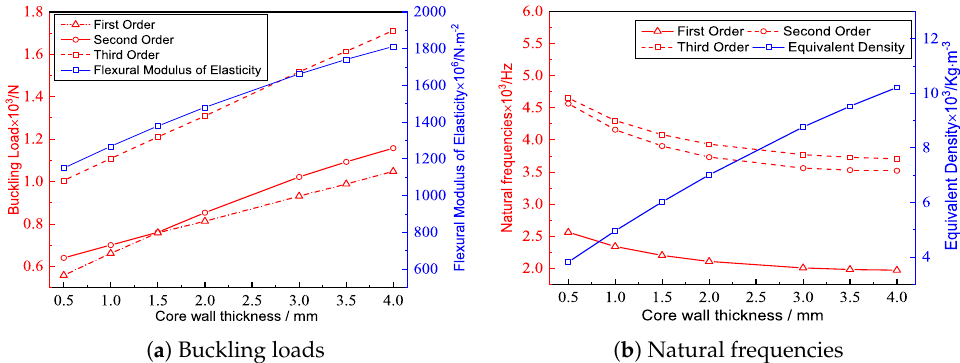
Figure 10. Effects of the core wall thicknesses on the buckling loads and natural frequencies of the triangular